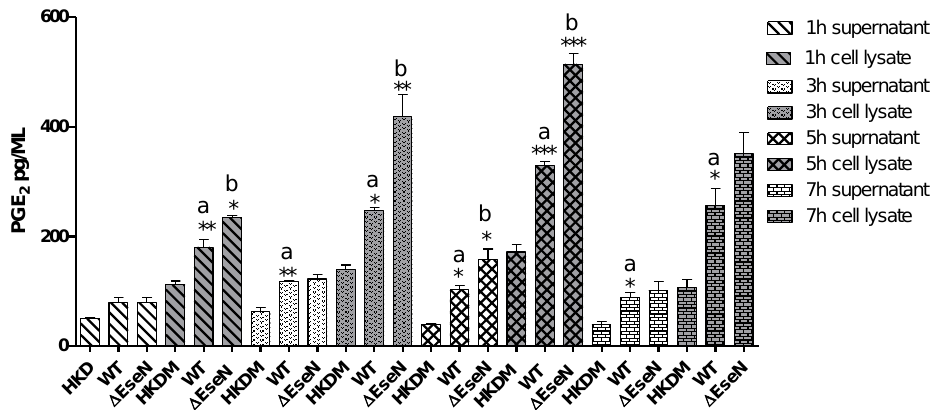
Figure 7. Expression of PGE2. Representative experiment from three independent experiments. Data represents levels of PGE2 expression in uninfected HKDM (HKDM), HKDM-WT (WT), and HKDM- ∆ EseN mutant ( ∆ EseN). Comparison between groups was based on One-way ANOVA with the Bonferroni procedure. Each column represents the mean ± SE; a: indicates significant difference between HKDM-WT (WT) and uninfected HKDM (HKDM), b: indicates significant difference between HKDM-WT (WT) and HKDM- ∆ EseN ( ∆ EseN) * p < 0.05, ** p < 0.01, *** p <